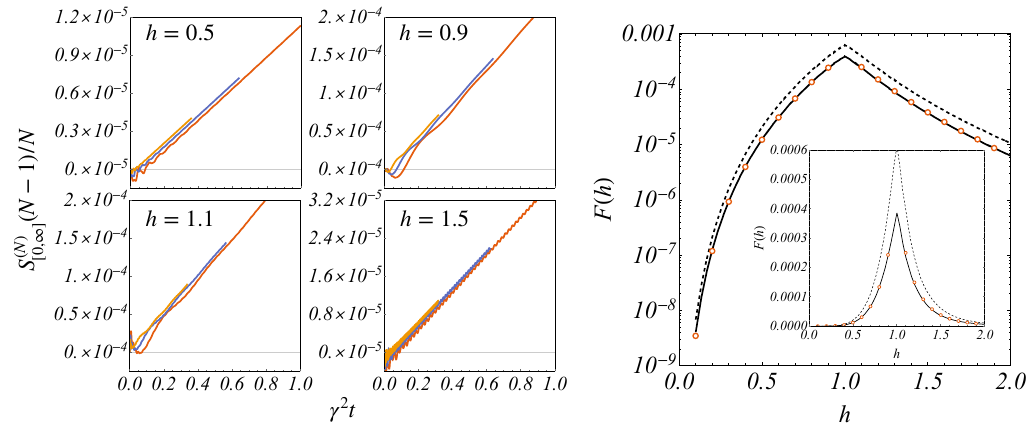
Figure 2: ( Left panels ) iTEBD evolution of the Rényi entropies for N = 4 and four representative values of the transverse field h . All curves have been vertically shifted by subtracting the corresponding ground-state entropy at t = 0. Different colors represent different quenches from γ = 0.1 (red), 0.08 (blue), 0.06 (yellow) to the noninteracting theory γ = 0. ( Right panel ) The numerical slope of the Rényi entropies in log scale (inset in linear scale), obtained through a linear fit of the time- dependent data sets (symbols), perfectly matches the analytical multiplet prediction (full black line). The black dashed line is the incorrect prediction based on the pair- structure ansatz of the initial state. The details on the iTEBD simulations can be found in App.